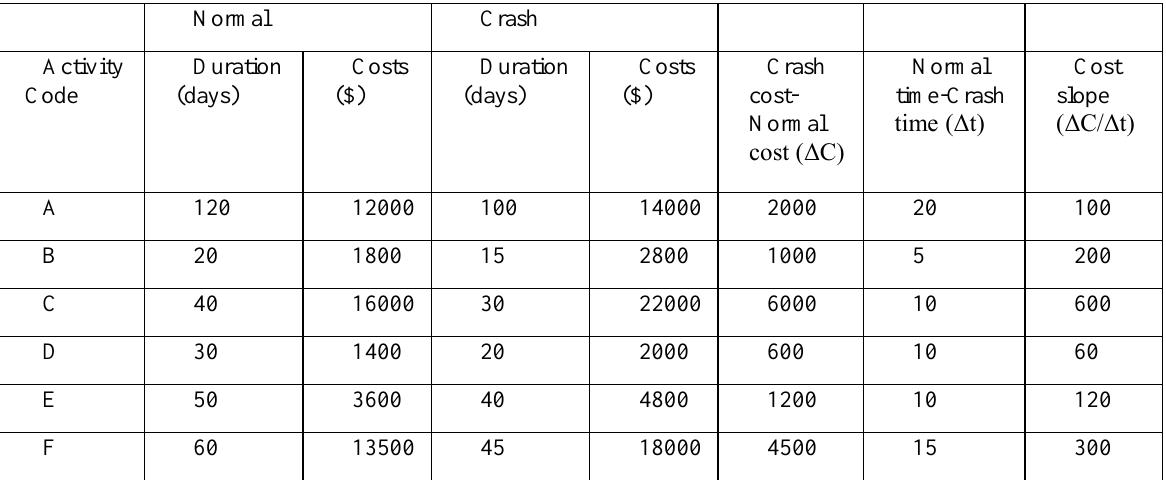
Table 4. Cost-time slope of the